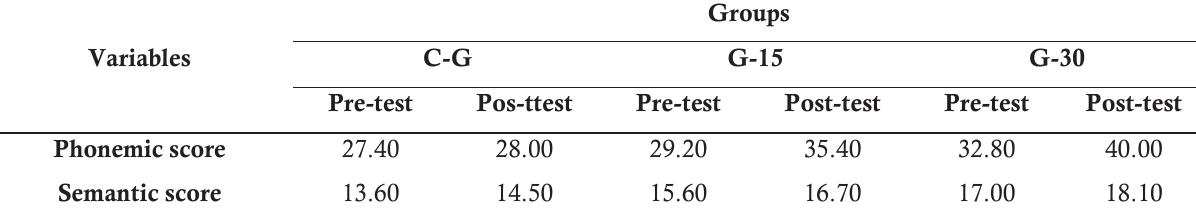
investigate the difference between mean score